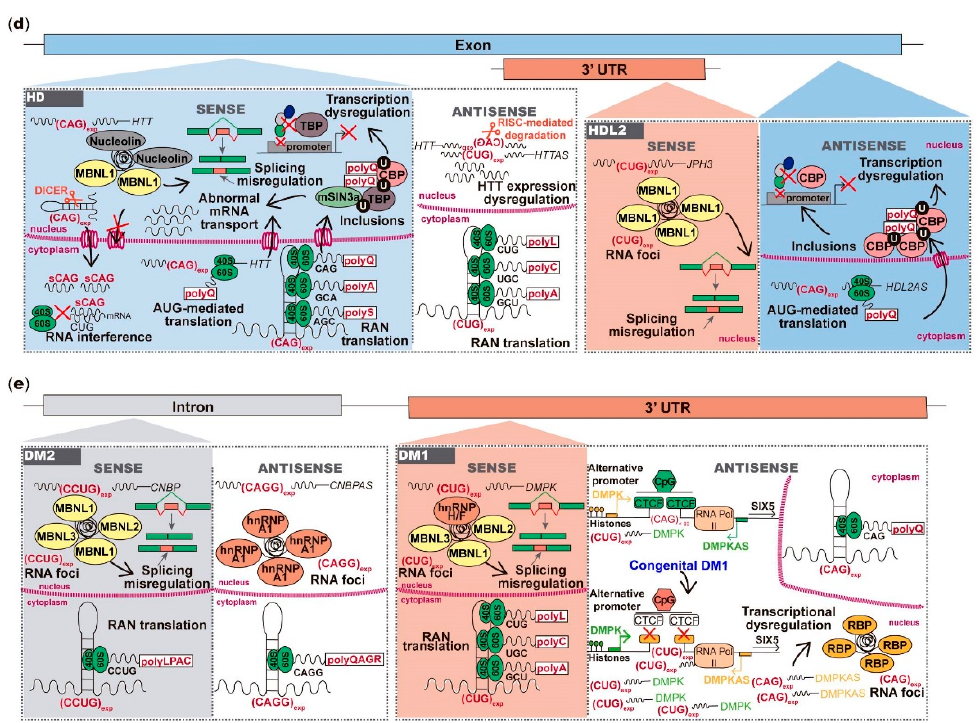
Figure 2. Toxicity mediated by microsatellite repeats bidirectionally transcribed in neurodegenerative and neuromuscular diseases. ( a ) The (CAG) exp RNA from ATXN2 is translated into polyQ that abnormally interact with proteins in stress granules; the ATXN2-AS (CUG) exp forms RNA foci with splicing factors leading to misplicing of other mRNAs; from the ATXN7 strand, the (CAG) exp RNA is translated into toxic polyQ that form nuclear inclusions with RNA and DNA-binding proteins, dysregulating transcription and cellular mRNAs splicing; in ATXN7AS , the (CUG) exp reduces CTCF-binding, causing SCAANT1 downregulation and consequent derepression of ATXN7 promoter, leading to ataxin-7 overexpression and global transcriptional dysregulation; from the ATXN8 strand, the (CAG) exp RNA is translated into toxic polyQ that form ubiquitin-positive intranuclear inclusions; the ATXN8OS (CUG) exp forms nuclear RNA foci causing misplicing or is RAN-translated. ( b ) In SCA36 and C9ORF72 FTD / ALS, sense and antisense strand RNAs aggregate in nuclear RNA foci or are translated into DRPs. ( c ) The FMR1 (GGC) 55–200 RNA forms nuclear foci or is RAN-translated into toxic peptides, which form intranuclear inclusions; from ASFMR1 strand, the (GCC) 55–200 RNA can be translated into toxic peptides, leading to intranuclear aggregation. ( d ) From the HTT strand, the (CAG) exp RNA can aggregate in nuclear RNA foci or form hairpins posteriorly cleaved by DICER; the (CAG) exp RNA is also translated into polyQ proteins, forming nuclear inclusions, or it is RAN-translated; in HTTAS orientation, the (CUG) exp RNA regulates the HTT RNA on a RISC-dependent manner and can be RAN-translated into polypeptides. In HDL2, the (CAG) exp RNA forms RNA foci, leading to splicing misregulation; polyQ can be generated from the antisense (CAG) exp RNA, impairing the cellular transcriptional activity. ( e ) In DM2, both sense and antisense repeat RNAs form foci or are RAN-translated in polytetrapeptides; in DM1 DMPK orientation, the (CUG) exp forms RNA foci with consequent misplicing of several cellular mRNAs. In congenitalDM1, the(CTG) > 1000 reducesCTCF-bindingandCpGmethylation, downregulatingantisense transcription; antisense transcription causes DMPK alternative promoter upregulation, leading to DMPK overexpression; DMPKAS CAGs also form RNA foci and are RAN-translated. DRP-dipeptide repeats; polyQ-polyglutamine; polyA-polyalanine; polyS-polyserine; polyL-polyleucine; polyC-polycysteine; polyP-polyproline; polyG-polyglycine; polyGP-poly-glycine-proline; polyPR-poly-proline-arginine; polyLPAC-poly-leucine-proline-alanine-cysteine;